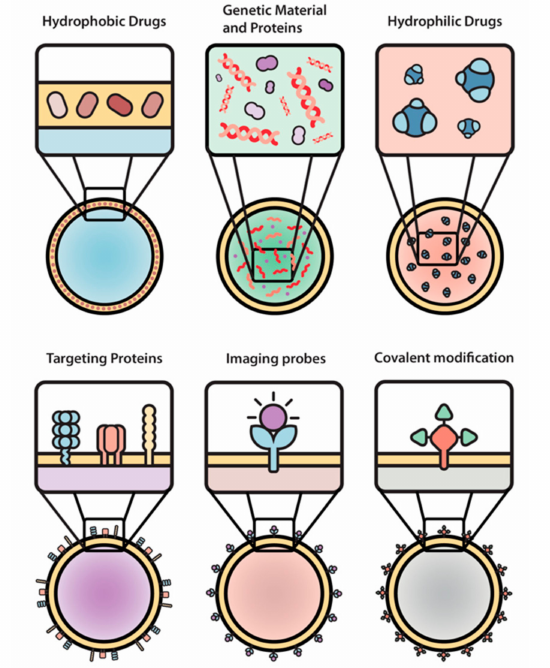
Figure 3. The engineering of EVs allows for a wide array of modifications of therapeutic payloads and surface moieties. Hydrophobic drugs, genetic material and proteins, hydrophilic drugs, targeting proteins, imaging probes, and covalent modifications were used as examples in this